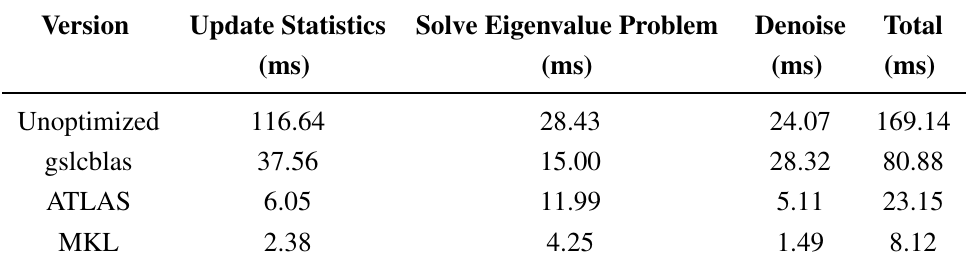
Table 1. Timing results using different BLAS (Basic Linear Algebra System) implementations.